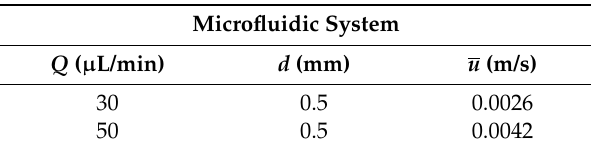
Table 2. Values for flow rate ( Q ), tubing diameter ( d ) and mean velocity (( u = (4 Q )/( π d 2 )) in the microfluidic system [23].